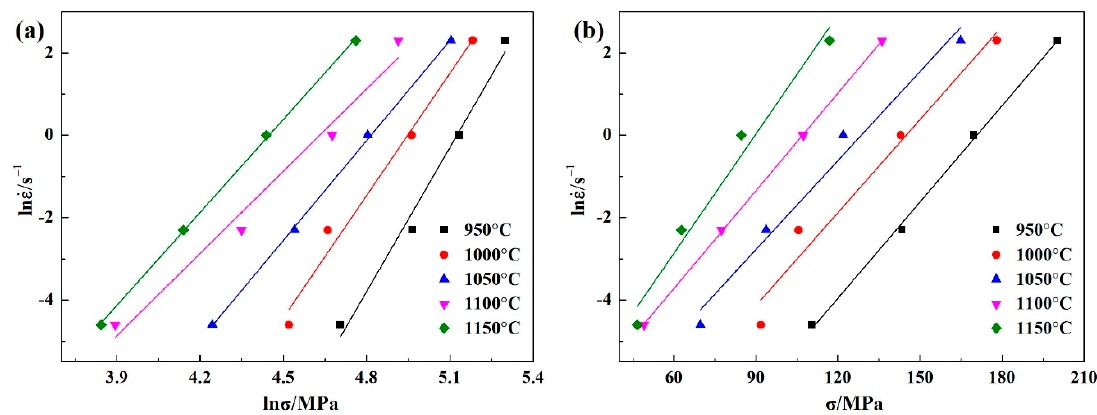
. ε . ε and ( b ) σ and ln under di ff erent